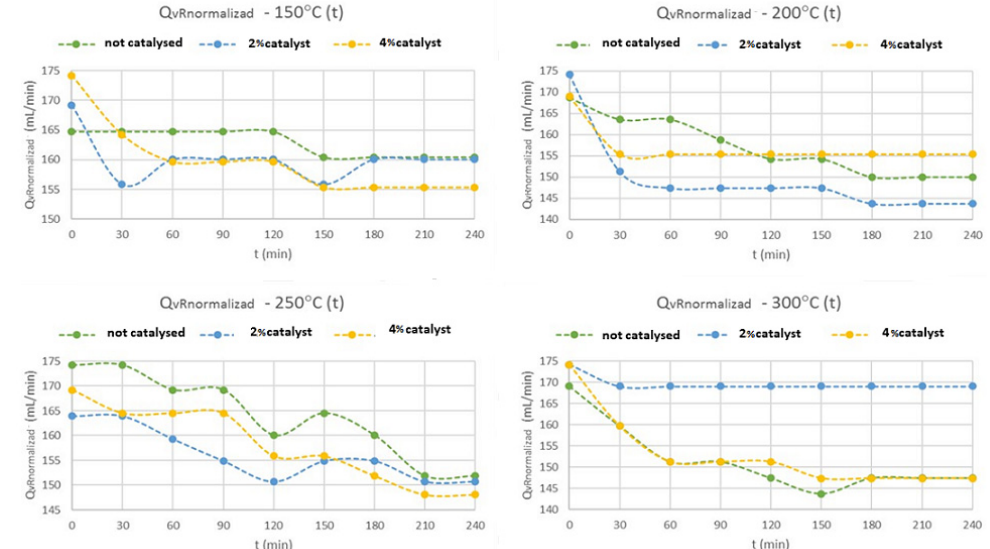
Figure 5. Comparison of the behavior of the volumetric flow rate of gases produced over the test time for the synthesis gas production tests for di ff erent amounts of catalyst and temperature (average values).